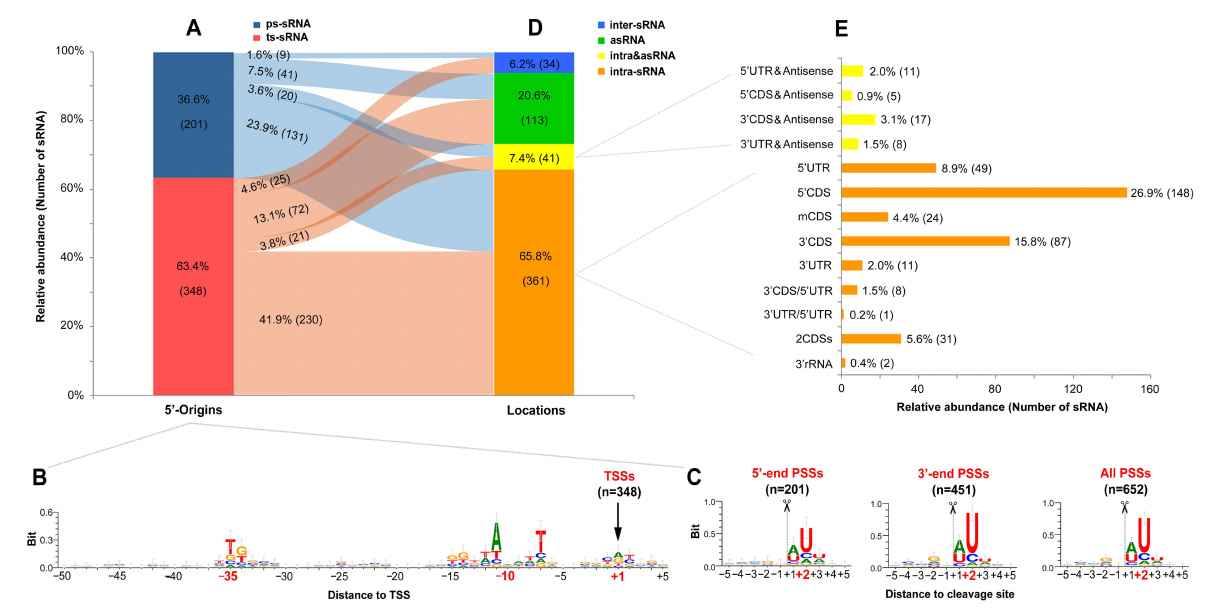
Figure 2. Origin and location patterns of sRNAs. ( A ) Distribution of sRNAs classified by the origins of 5 (cid:48) -ends. ( B , C ) show the sequence logos of neighboring regions of TSSs and PSSs, respectively. The “ − ” and “+” before the numbers represent the upstream and downstream positions, respectively, and the featured positions are shown with bold and red fonts. ( D , E ) show the distributions of sRNAs classified by their locations relative to the genomic annotations. The percentage represents the ratio of one type of sRNA in the total, and the following number in the bracket shows the corresponding amount. The relationships between ( A ) and ( D ) are connected by a Sankey diagram created by using the SankeyMATIC (https://sankeymatic.com/build/, accessed on 28 February